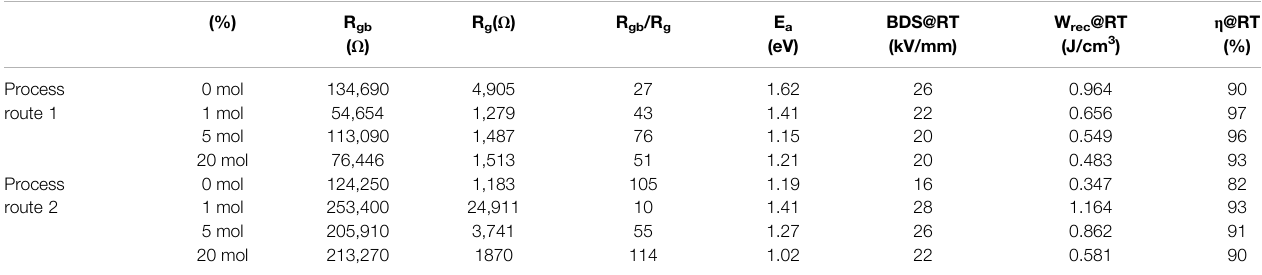
TABLE 1 | BDS and fi tting results of R gb , R g , and E a for CST-ZnO ceramics prepared via process routes 1 and 2